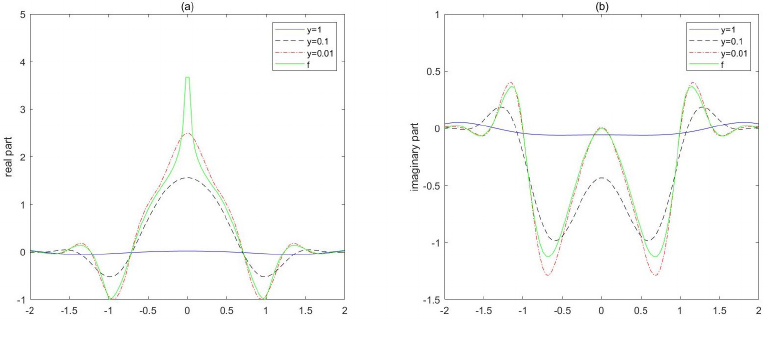
Figure 5. ( a ) Real part graph of f ε , ( b ) imaginary part graph of f ε .